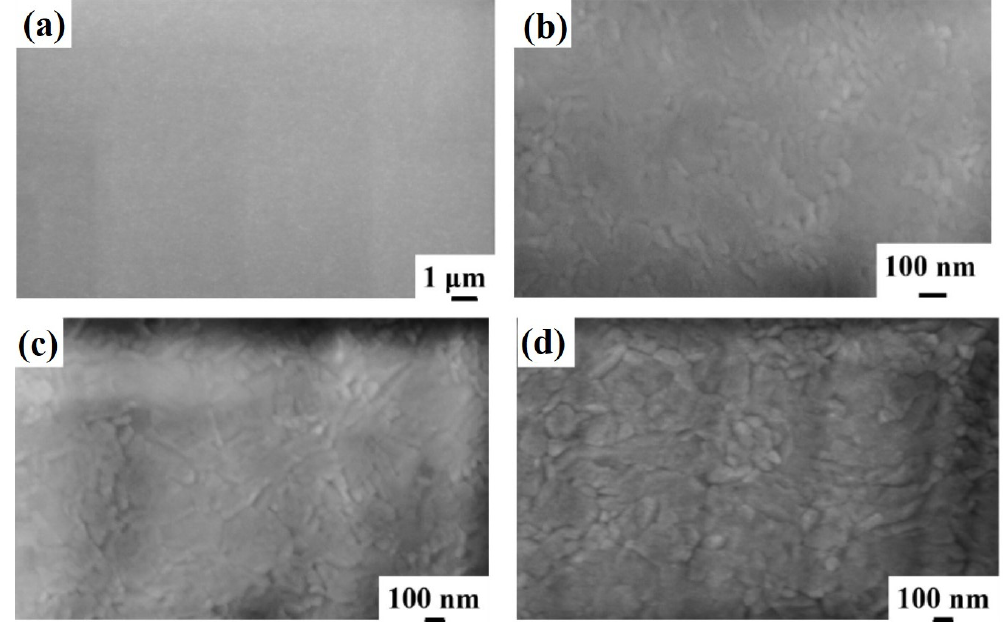
Figure 5. Representative plan-view SEM images of the Al surface for the sample: ( a , b ) 3A (Si/W/Al) with increasing magnification from ( a ) to ( b ); ( c ) 3E (Si/W/Al + 350 °C 30 min); ( d ) 3F (Si/W/Al + 400 °C 15 min).